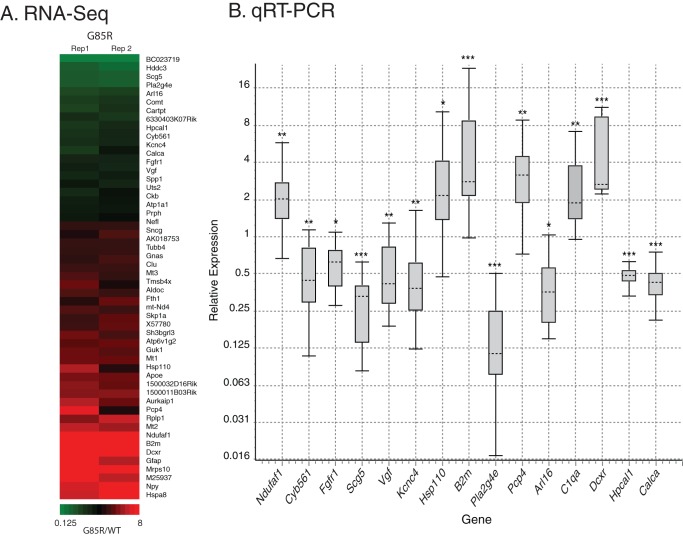
Differential expression in G85R motor neurons.A. Heatmap of selected genes from Table S2 significantly differentially expressed (raw p-value <0.005) between wild-type and G85R SOD1-YFP mice. For each gene listed, the ratio of RPKM values (G85R/WT) for individual pairs of biological replicates (Rep1, Rep2) is plotted according to the color code below. B. Validation of differentially expressed genes in G85R by qRT-PCR. Shown are box plots representing relative expression values of each gene in G85R versus wild-type motor neurons. Upper whisker represents top 25% of values, box represents the middle 50% of values, and lower whisker represents bottom 25% of values. Median value is indicated by horizontal dashed line. Statistical significance calculated by REST 2009 [37] is indicated by *  =  p<0.05, **  =  p<0.005, ***  =  p<0.0005. RNAs from at least three different mouse pairs were compared for each gene. Note that the Hsp110 and B2m validations used one exon-junction-spanning and one non-spanning primer set; minus reverse transcriptase controls for these samples were negative for DNA contamination. The expression changes in the left nine genes were validated with 0.19 ng of total RNA, while the remaining six were validated with 1.5 ng of total RNA.